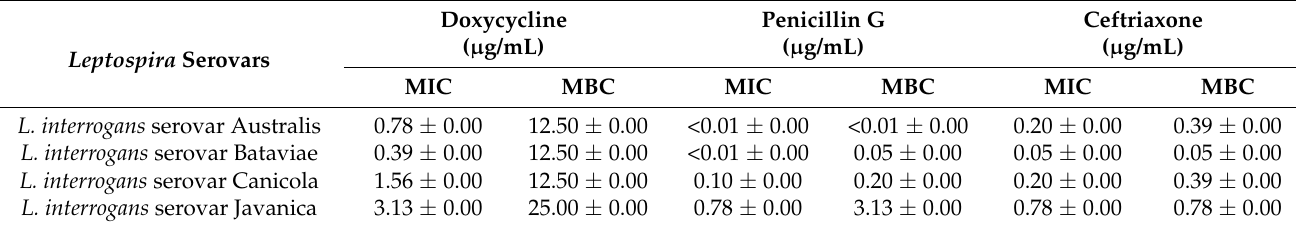
Table 2. MIC and MBC values (mean ± SD) of antibiotics on Leptospira serovars in triplicate.